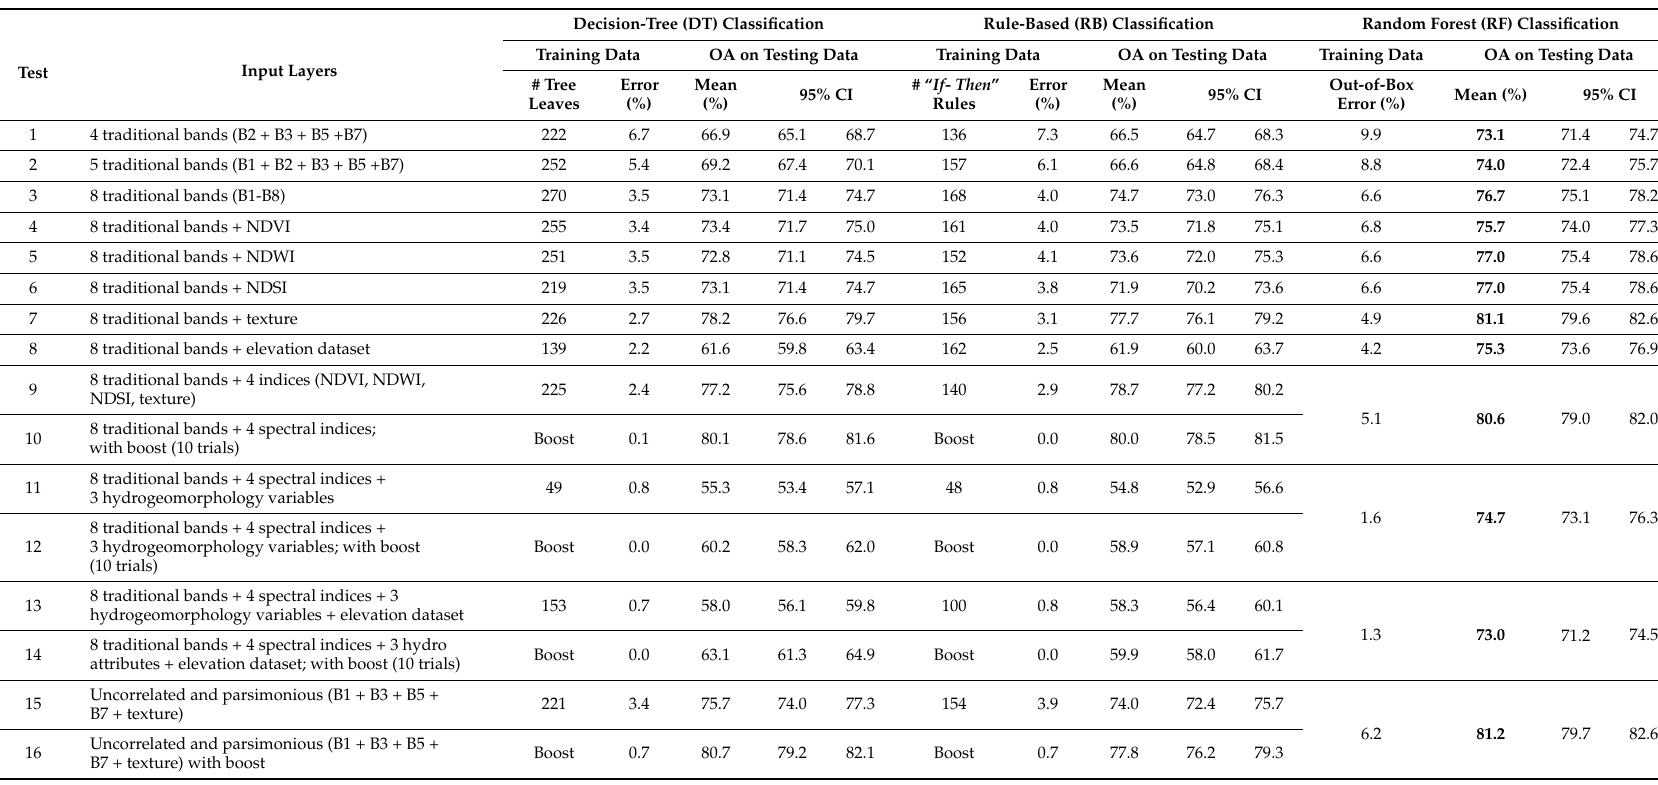
Table 2. Contrasting the accuracy between three classifiers and combinations of predicator variables. The highest overall accuracy (OA) per test is identified with bold